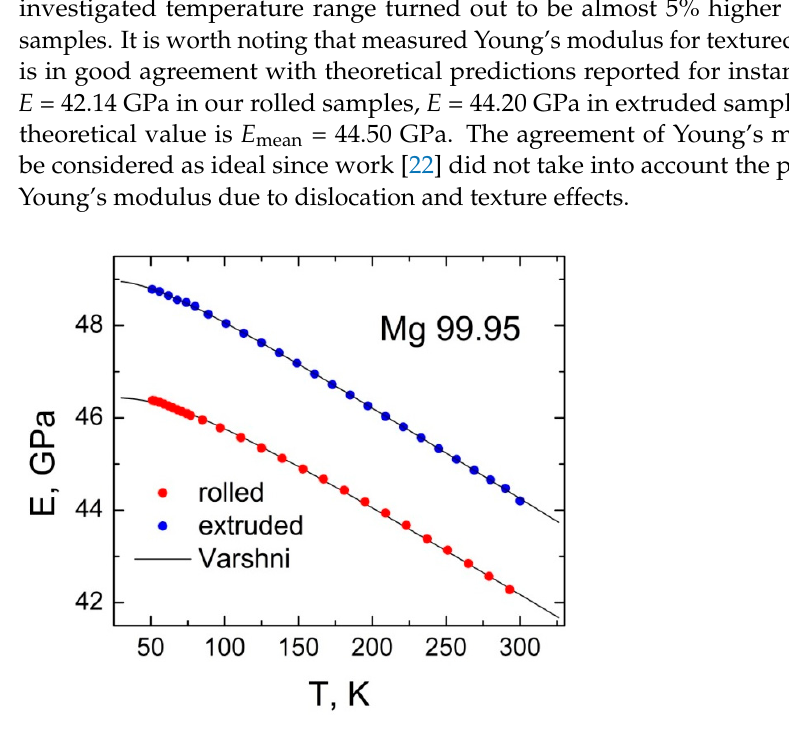
Figure 9. Temperature dependences of the dynamic Young’s modulus of rolled and extruded Mg samples. Solid lines show the approximations made using Equation (8).